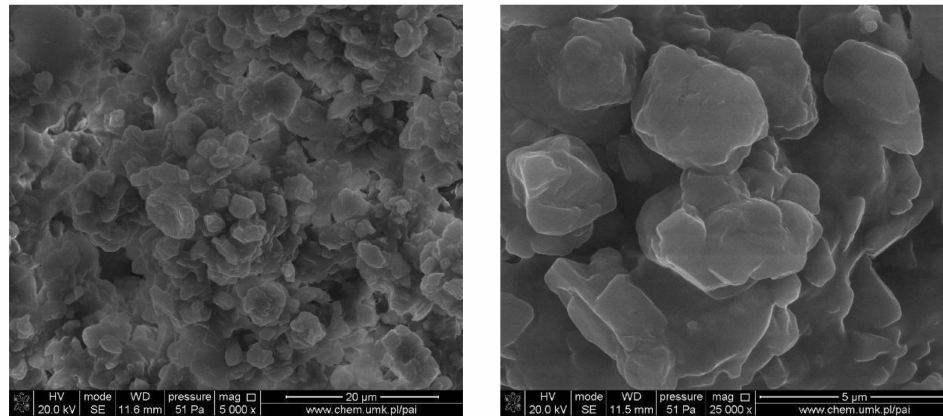
Figure 5. SEM microstructure of EPDM